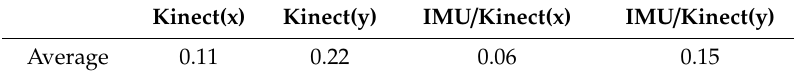
Table 10. Absolute values of the coordinate errors (in meters).